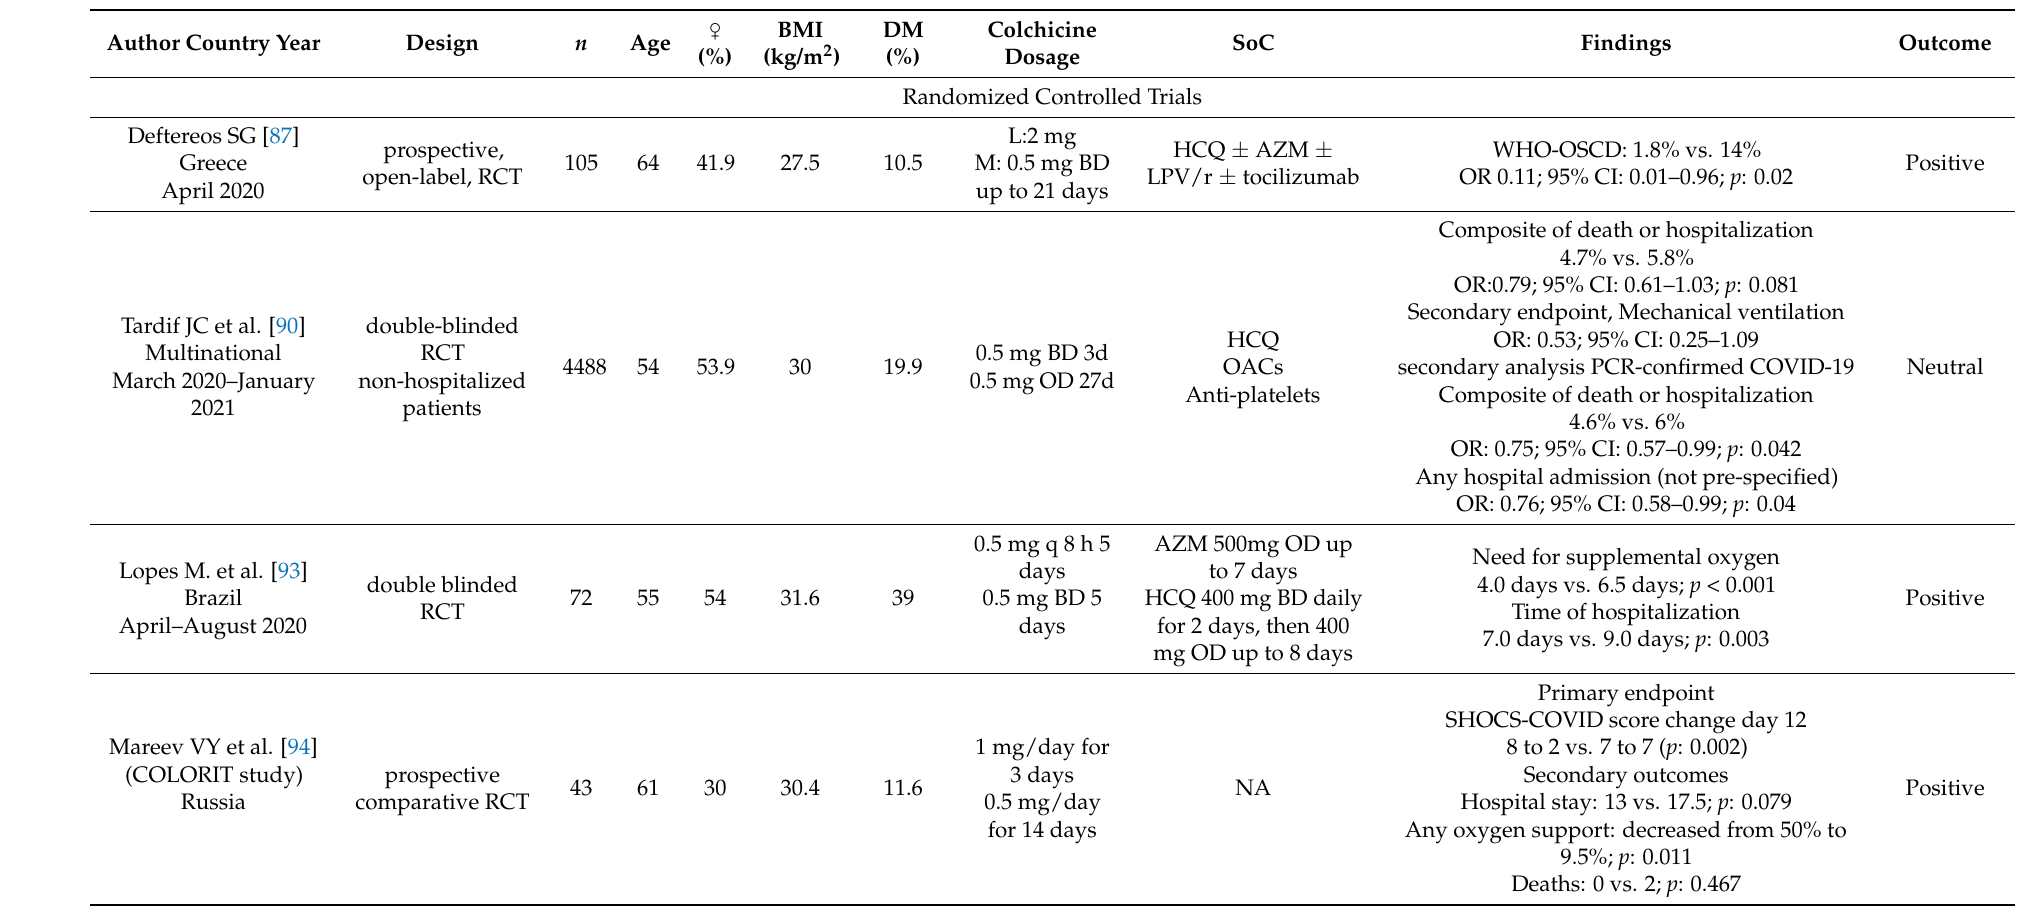
Table 2. Main characteristics and outcomes of completed studies investigating the impact of colchicine in SARS-COV-2 infected